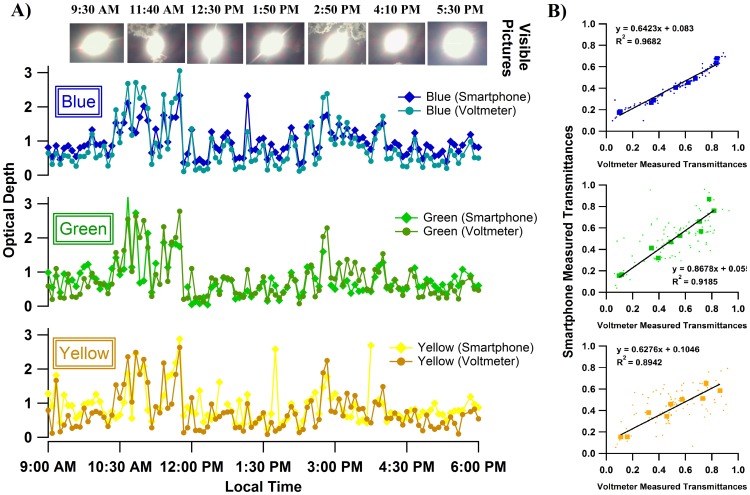
Optical depths measured with smartphone sun photometer and reference device.Panel (A) – Optical depths at Lubbock, TX from 9:00 AM to 6:00 PM on September 1 2013. Measurements were made with both smart phone sun photometer and reference method on blue, green and yellow channels. On this day, optical depths shifted up and down because of the existence of clouds in the sky as seen in the photographs. (B) – Comparison of transmittance measurements using smartphone and reference method. The y-axis shows atmospheric transmittance measured by the smartphone while x-axis shows transmittance measured by reference method. Small dots illustrate all measurements made with the two devices. Larger square markers are median values for different bins. Best-fit lines were determined by orthogonal distance regression from medians.